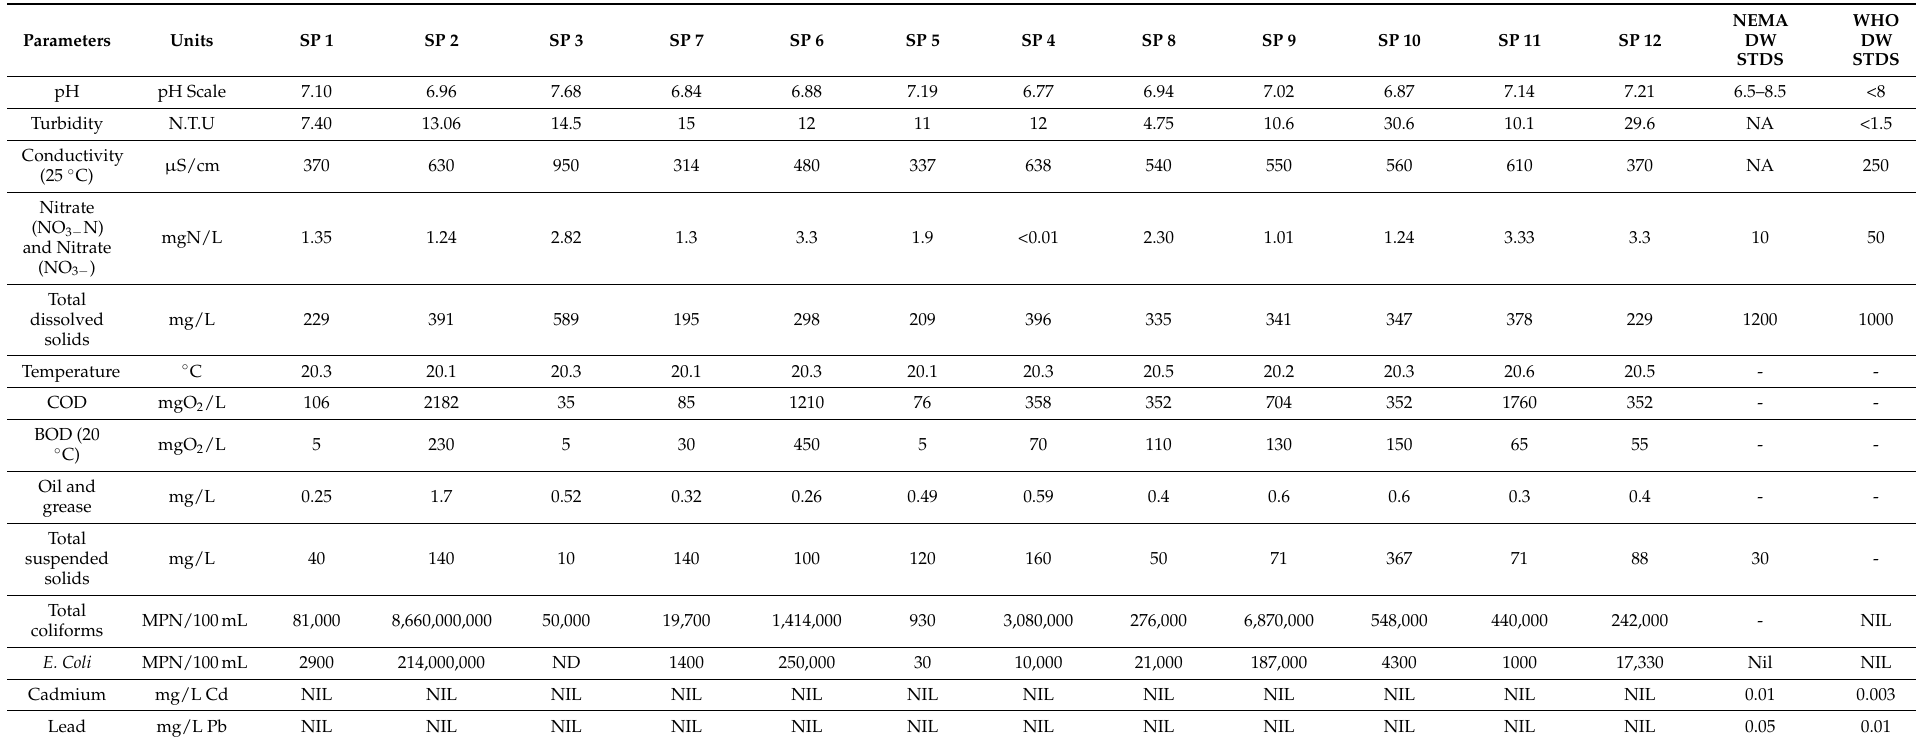
Table 5. Ngong River water quality levels (wet